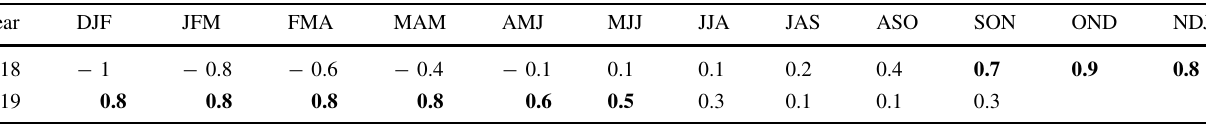
Table 5 Oceanic Nin˜o Index (ONI) values for 2018 to 2019 (Bold numbers = El Nin˜o event). DJF December–January–February, and so forth. A ‘‘season’’ a 3-month running mean. An episode 5 consecutive 3-MRMs at C 0.5 (cid:3) C and above. Source : NOAA (2019b)